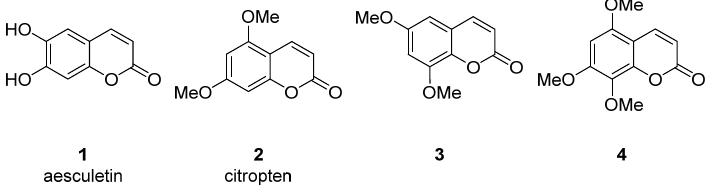
Figure 3. Anti-HIV hydroxy- and methoxycoumarins 1 – 3 .